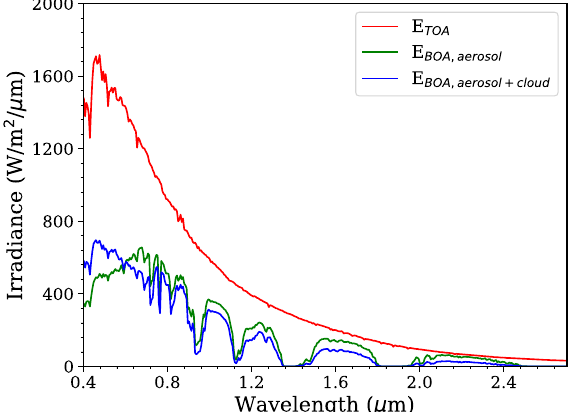
Figure 4. Hyperspectral (400 spectral bands) solar TOA irradiance (red) and BOA total irradiance simulated with clouds (blue) and no clouds (green) at 11:00. Atmosphere parameters are derived through the inversion